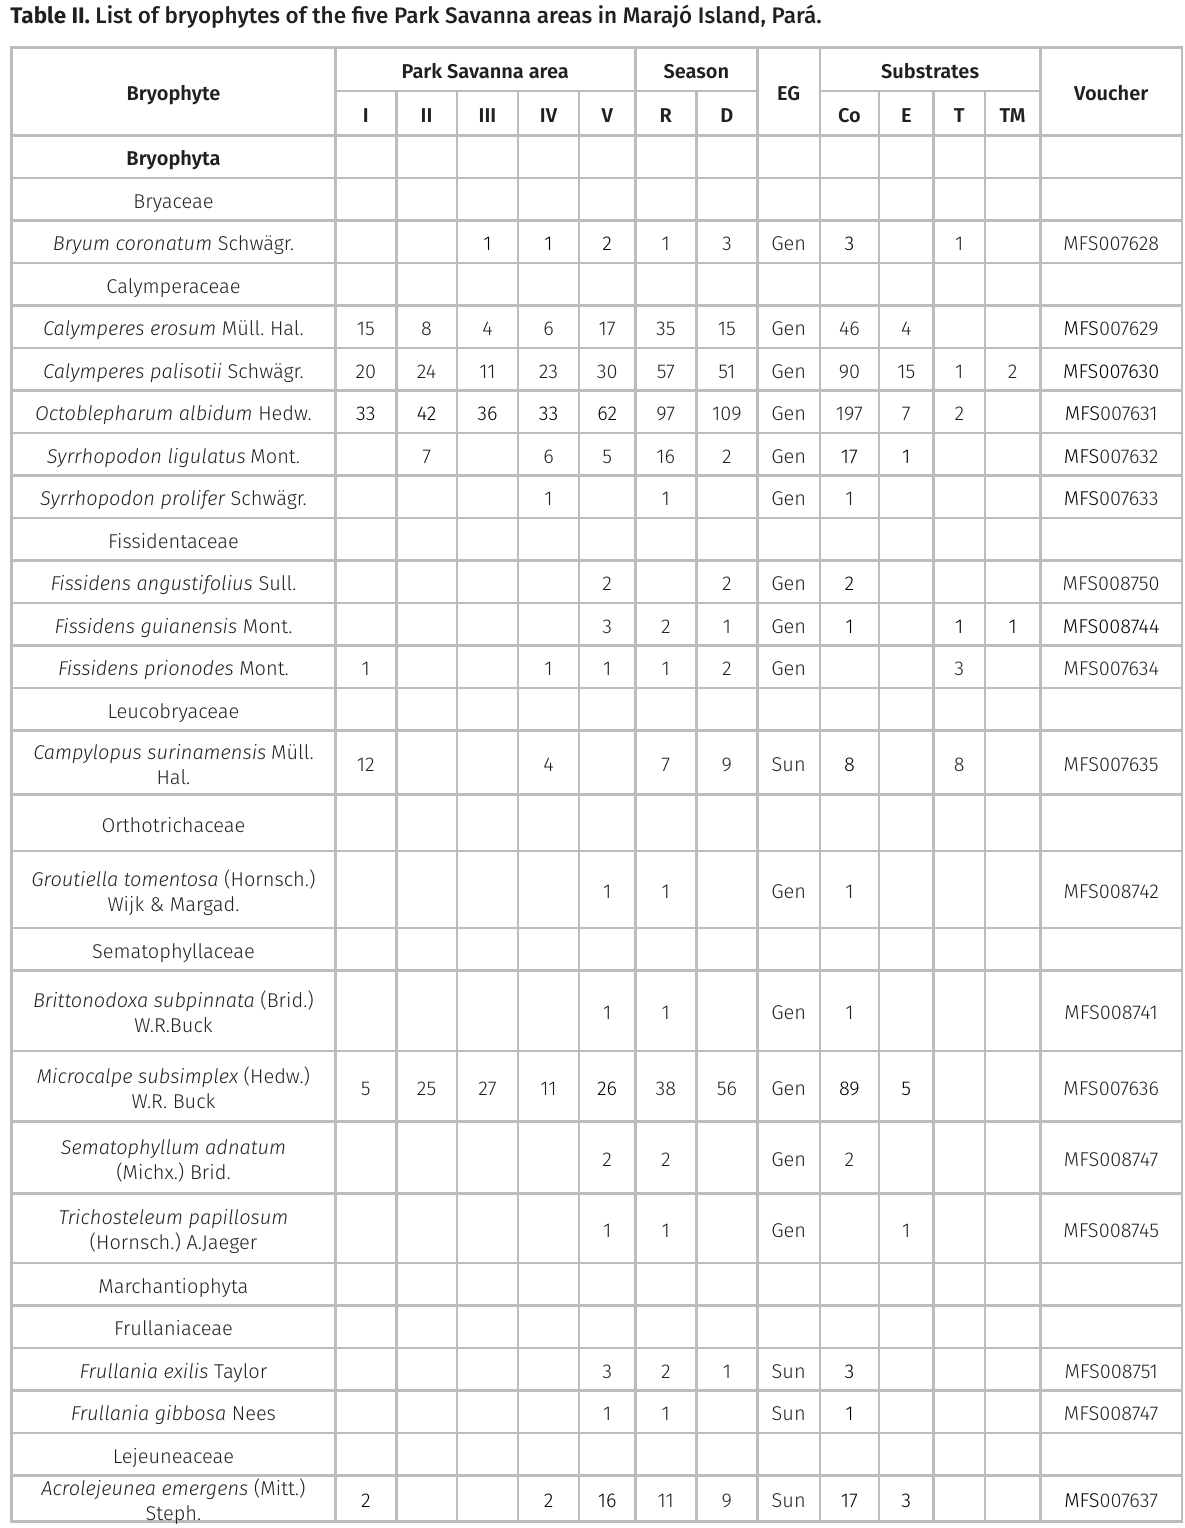
Substrates EG Voucher